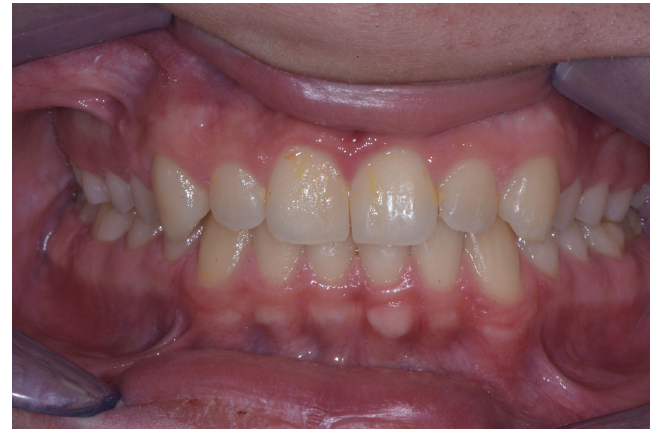
Figure 8: Clinical view at 2 years of